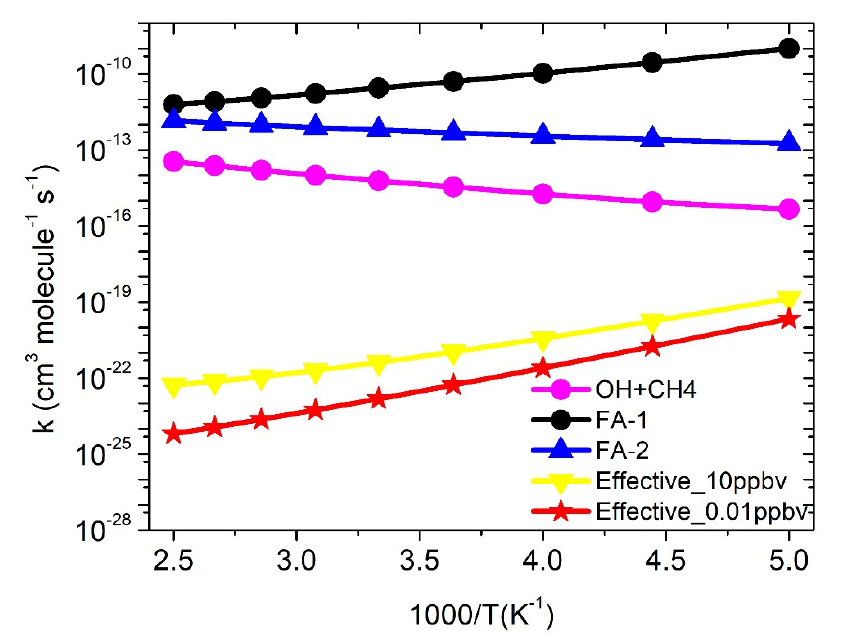
Figure 5. Rate constants for · OH + CH 4 and · OH + CH 4 (+HCOOH) reactions. The presented rate constants are for assumed the concentration of HCOOH at 0.01 ppbv (2 × 10 8 cm − 3 molecule) and 10 ppbv (2 × 10 11 cm − 3 molecule). FA-1 and FA-2 are rate constants without FA concentration.